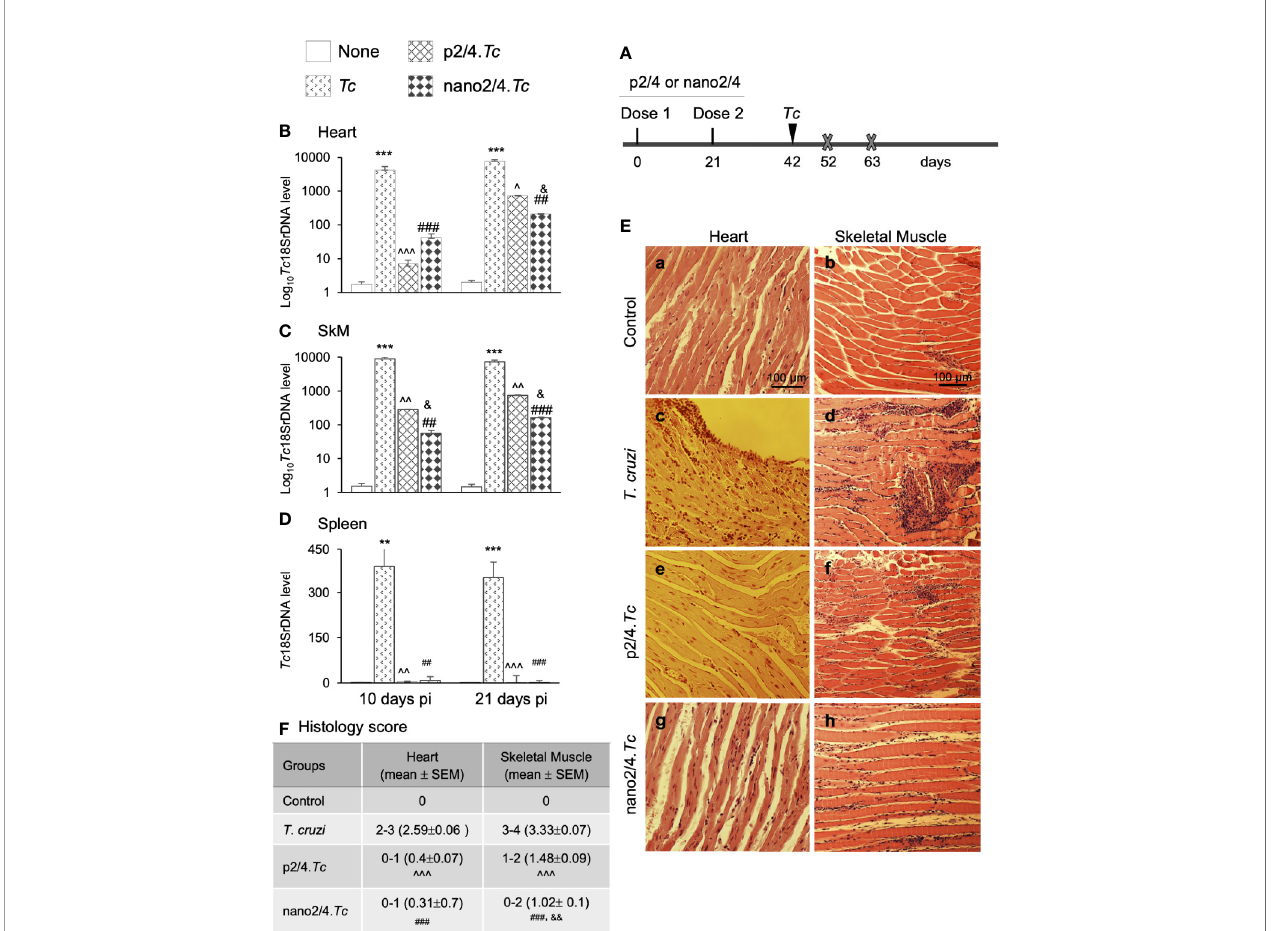
FIGURE 1 | Prophylactic ef fi cacy of nanovaccine against acute parasitemic phase. (A) Schematic of experimental design. C57BL/6 mice were immunized with p2/4 or nano2/4 experimental vaccines on day 0 and day 21, and infected with T. cruzi (SylvioX10 trypomastigotes, 10,000 parasites per mouse) on day 42. Non-infected mice were used as controls. Mice were euthanized (marked by a cross) on day 52 and day 63 corresponding to day 10 and day 21 post-infection (pi), respectively. (B – D) Tissue parasite burden. Total DNA was isolated from heart (B) , skeletal muscle (C) , and spleen (D) tissue at day 10 and day 21 pi, and real-time qPCR was performed to measure Tc18SrDNA levels (normalized to murine Gapdh ). Data (mean ± SEM) are representative of duplicate observations per sample ( n ≥ 5 mice per group per experiment). (E, F) Tissue in fl ammatory in fi ltrate in acutely infected mice (± nano vaccine). Paraf fi n-embedded 5-µm tissue sections were obtained at 21 days pi and examined by hematoxylin/eosin staining. Shown in (E) are representative images of the heart and skeletal muscle tissue sections from non-vaccinated/ non-infected (a, b), non-vaccinated/ T. cruzi- infected (c, d), p2/4. Tc (e, f), and nano2/4. Tc (g, h) groups of mice (magni fi cation: 20×). In fl ammatory score was calculated as described in Materials and Methods, and presented in (F) . Signi fi cance was calculated by student ’ s t-test (* controls vs. Tc only) and one-way ANOVA/ Tukey ’ s ( ^ T. cruzi only vs. p2/4. Tc , # T. cruzi only vs. nano2/4 .Tc and & p2/4. Tc vs. nano2/4. Tc ). One, two, and three symbol characters were used to annotate the p values of <0.05, <0.01, and <0.001,